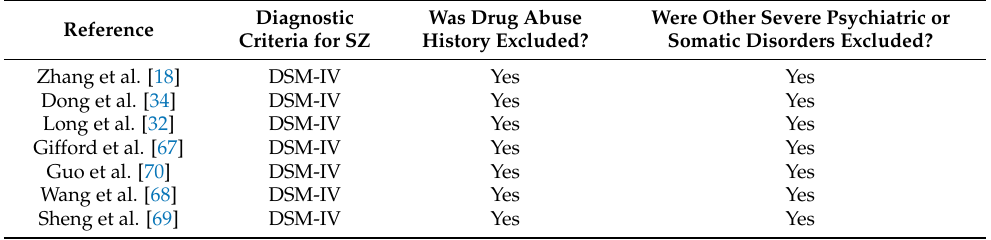
Table A1. Additional information about the studies on schizophrenia (SZ) as mentioned in this manuscript. DSM, Diagnostic and Statistical Manual of Mental Disorders.